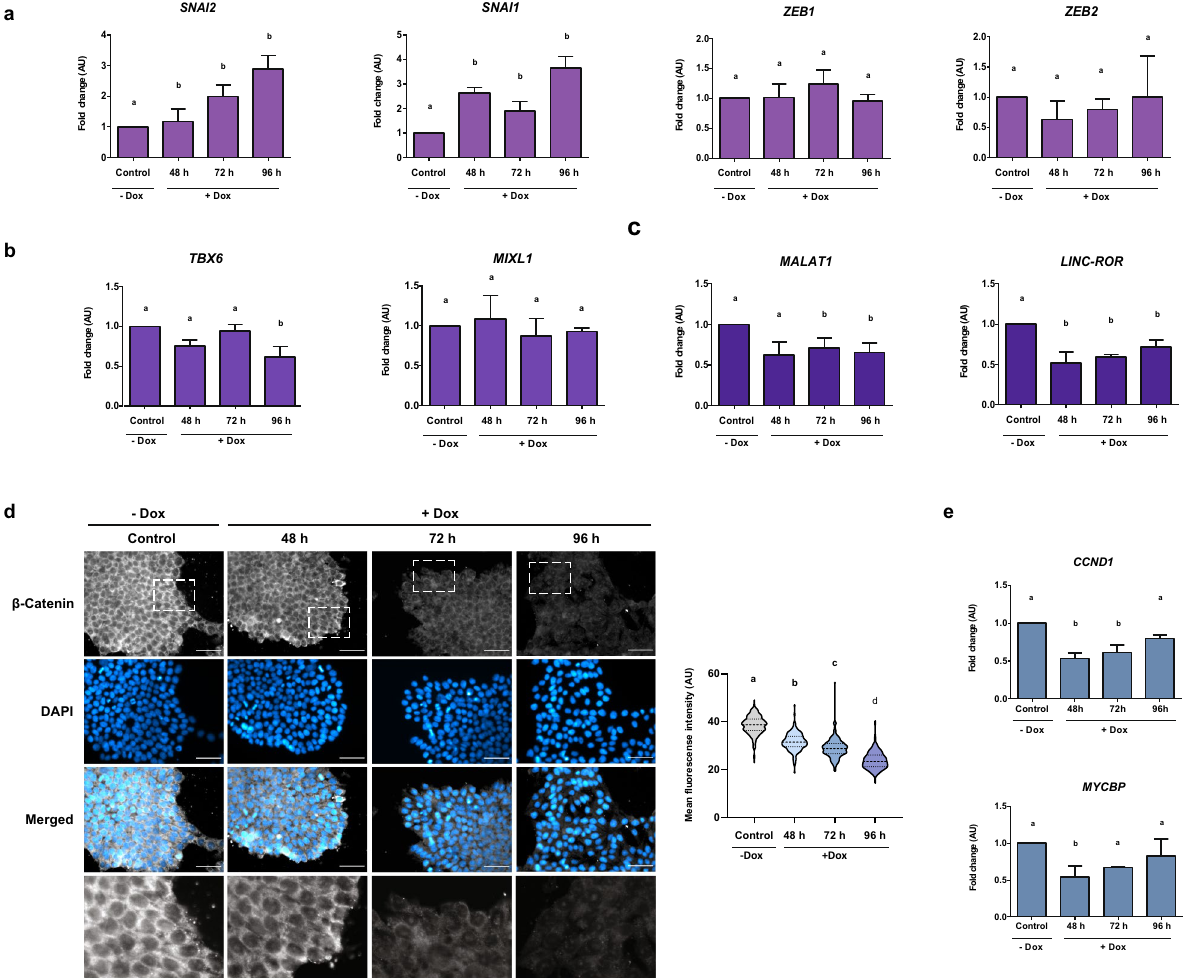
Figure 4. E-cadherin decrease activates the initiation of EMT. qPCR analysis of ( a ) genes involved in EMT such as SNAI1 , SNAI2 , ZEB1 and ZEB2 and ( b ) genes of early mesoderm precursor TBX6 and MIXL1 when E-cadherin is downregulated. ( c ) Relative expression level of LINC-ROR and MALAT1 , two lnc-RNAs that act as regulators of EMT were measured by qPCR. AU is the abbreviation for arbitrary units. Results are represented as mean ± SD (n = 5). ANOVA with post hoc Tukey. Different letters indicate significant differences of groups compared to control condition (p < 0.05). ( d ) Immunofluorescence and quantification of mean fluorescence intensity of β-catenin (grey) in cells treated with Dox. Nuclei were stained with DAPI (blue). Magnification of dotted areas are shown in black and white colors. Scale bar 50 µm. Representative images of at least three experiments are shown. Results are represented as mean ± SD (n = 3). ANOVA with post hoc Tukey. Different letters indicate significant differences between groups (p < 0.05). ( e ) Relative mRNA levels of c-myc ( MYCBP ) and cyclin D1 ( CCND1 ) were determined by qPCR. Data are presented as mean ± SD (n = 4). ANOVA with post hoc Tukey. Different letters indicate significant differences of groups compared to control condition (p <